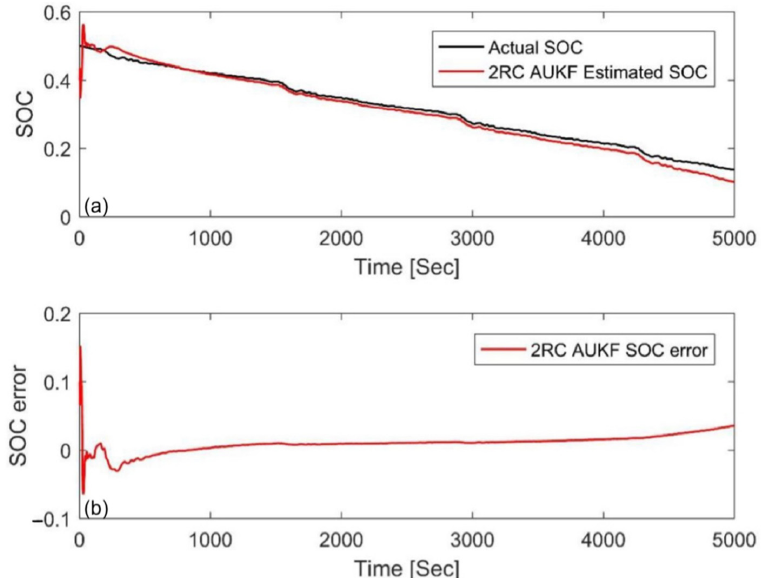
Figure 10. Estimation results at an initial SOC of 40% via the FUDS at 0 °C. ( a ) SOC estimation comparison curve; ( b ) SOC estimation error.